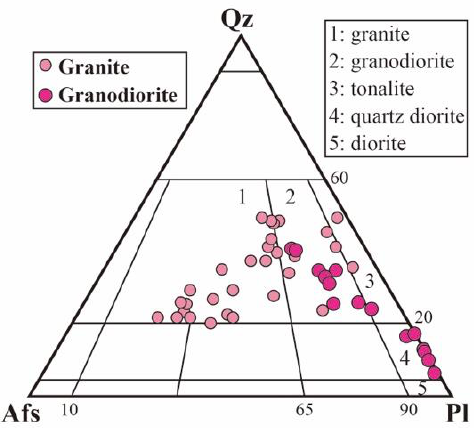
Figure 3. Modal values of the granodiorite and granite plotted in quartz (Qz) – alkali feldspar (Afs) – plagioclase (Pl) diagram. The granodiorite shows lithological variations from quartz diorite to granodiorite. The granite is mostly plotted within the granite field, but some samples show tonalite to granodiorite compositions.